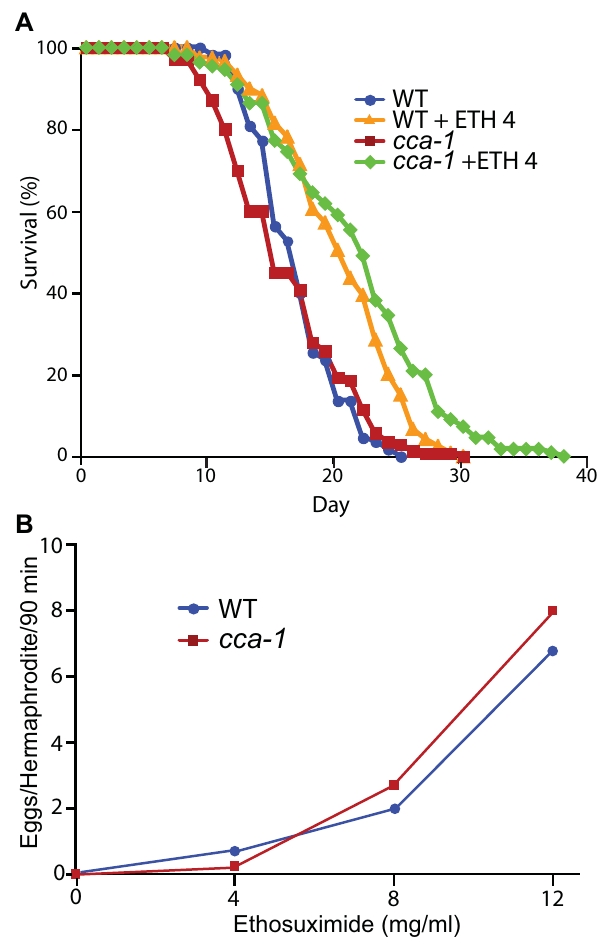
Figure 1. Ethosuximide treatment extended lifespan and stimulated egg laying in cca-1 null-mutants. (A) Ethosuximide extended the lifespan of cca-1(gk30) mutants. Wild-type or cca-1(gk30) hermaphrodites were cultured with 0 mg/ml or 4 mg/ml ethosuximide